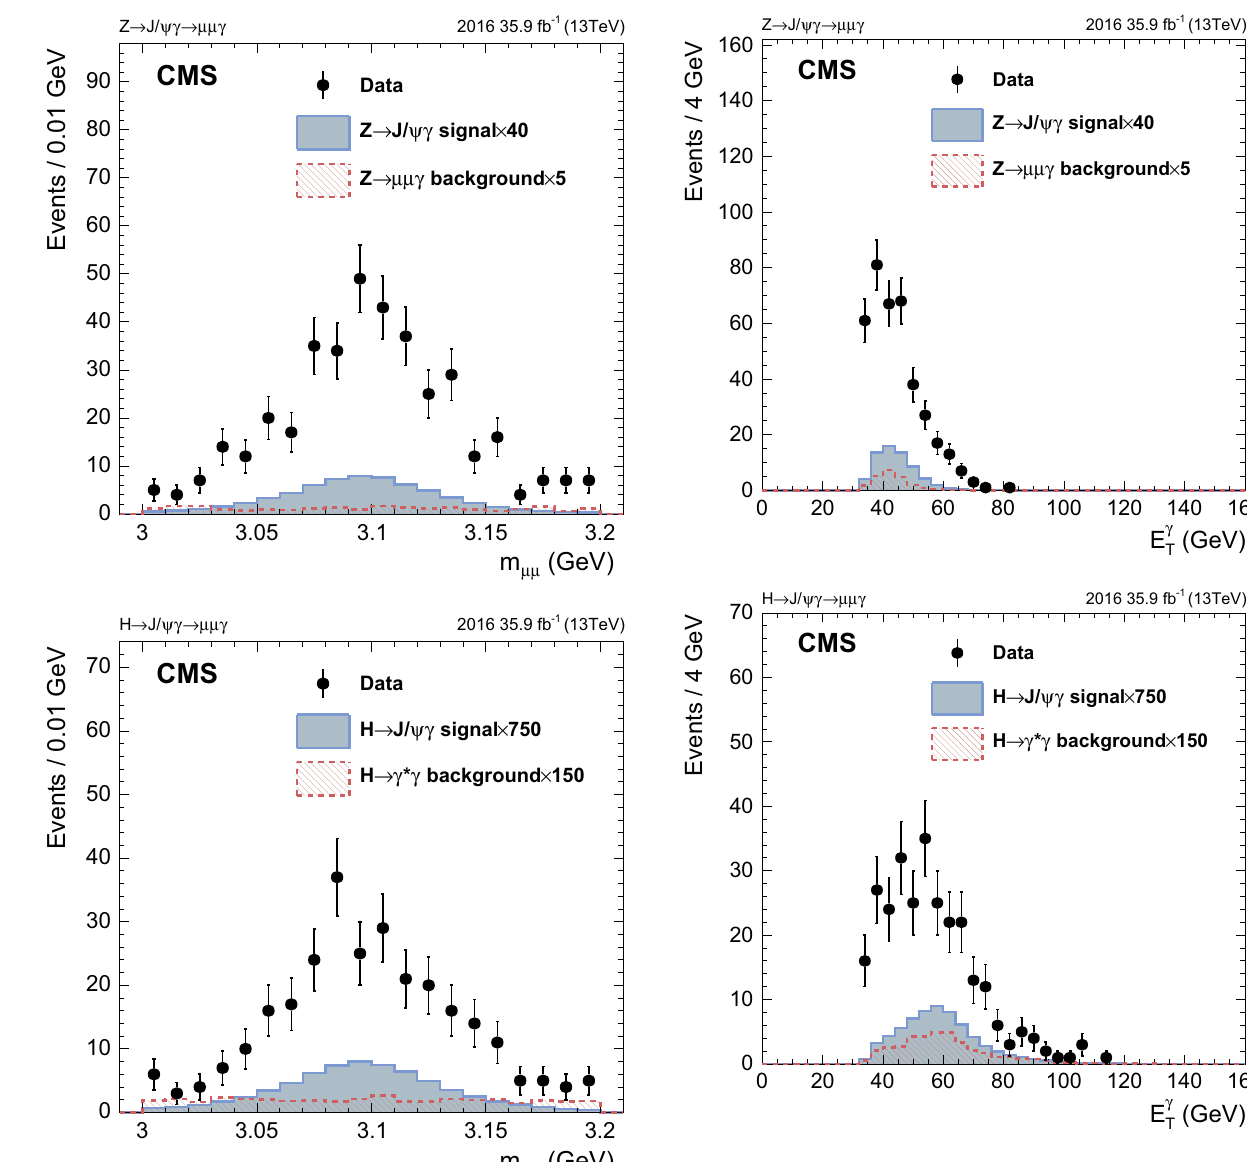
L xy is defined either to be positive or negative. The positive (negative) value indicates that the angle between the L xy vec- /ψ is smaller (larger) than π/ 2. The tor and the vector of p J T distributions suggest that the J /ψ candidates reconstructed in data, like the signal events, are produced promptly at the pp interaction point, rather than coming from displaced heavy hadron decays.